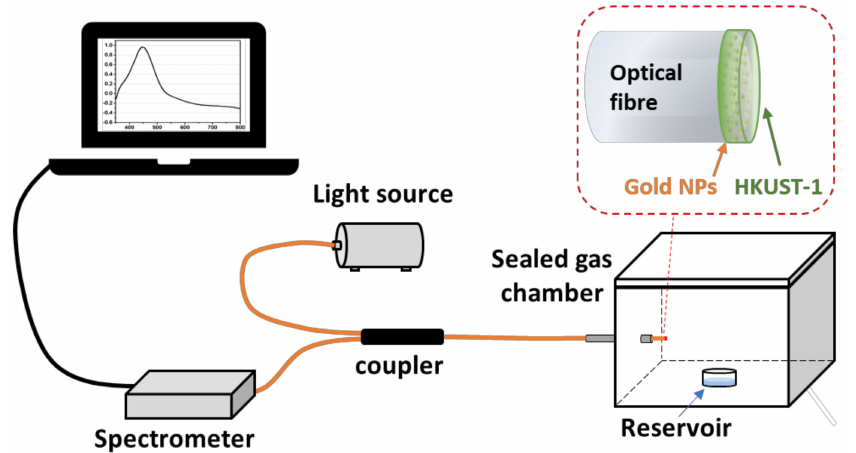
Figure 3. Experimental set-up of the optical fibre sensors (OFS) for sensing organic vapours. The inset figure illustrates the configuration of the coated fibre